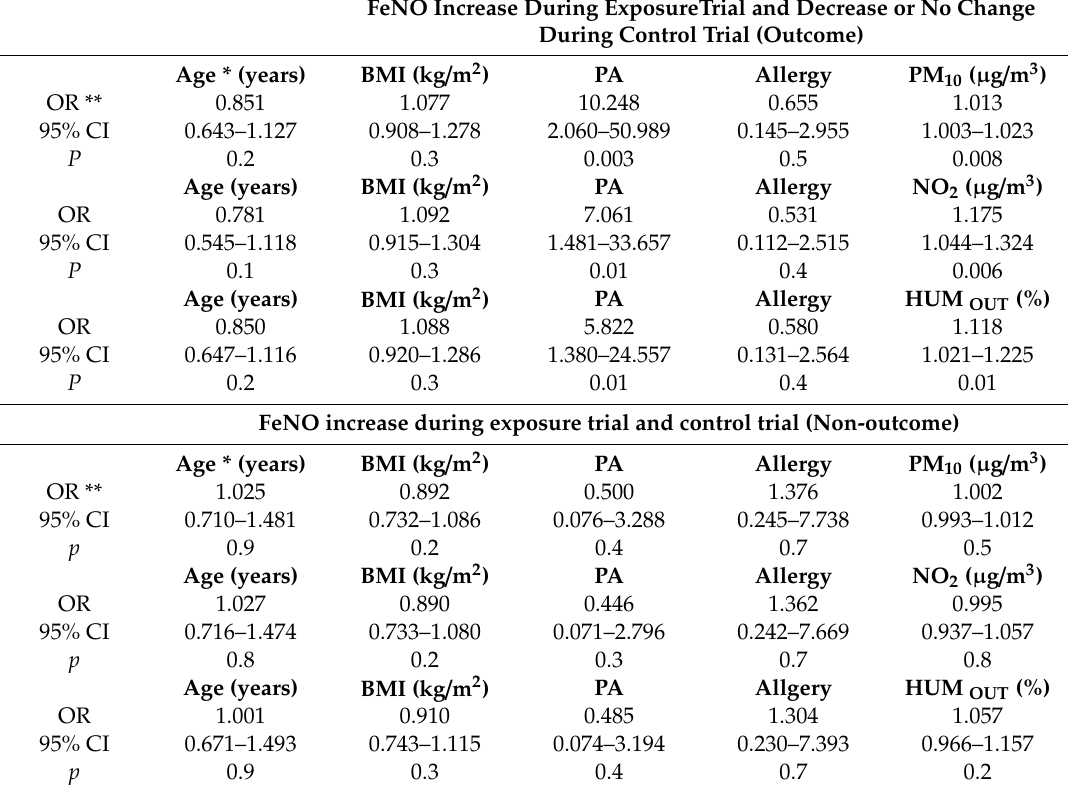
Table 5. Multivariable logistic regression analysis of increases in FeNO only during exposure trial and PM 10 , NO 2 and air